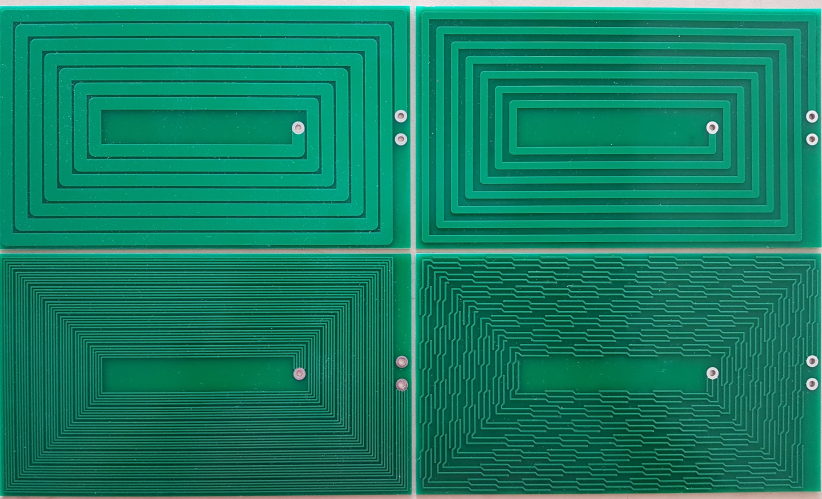
Figure 15. Seven-turn PCB windings with solid 5 mm ( Top left ), solid 3 mm ( Top right ), multi-strands ( bottom left ) and Litz style ( bottom right ).